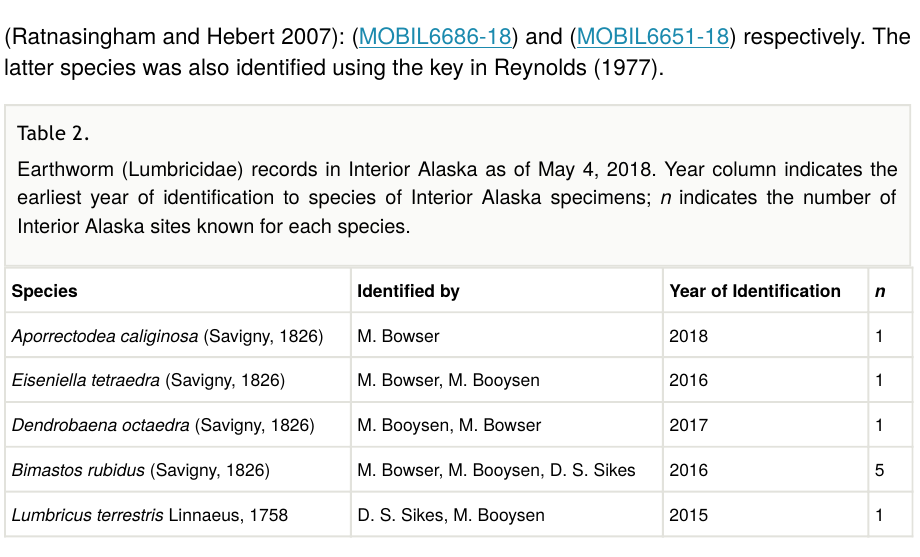
(Ratnasingham and Hebert 2007): (MOBIL6686-18) and (MOBIL6651-18) respectively. The latter species was also identi fi ed using the key in Reynolds (1977).